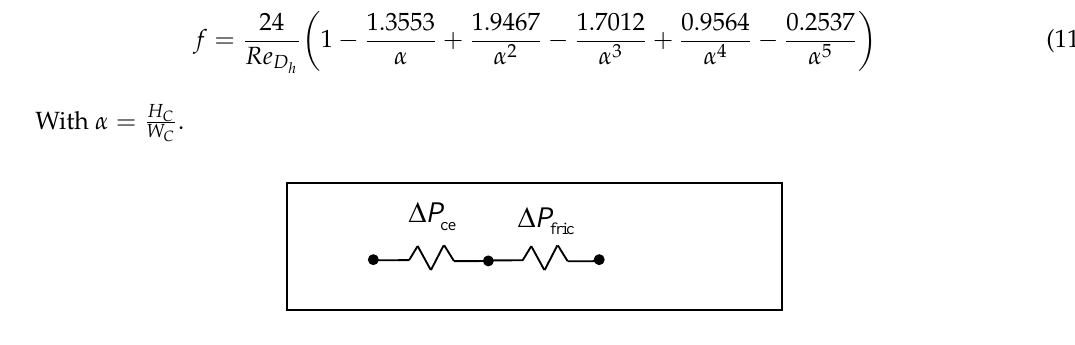
Figure 3. Pressure drop network.